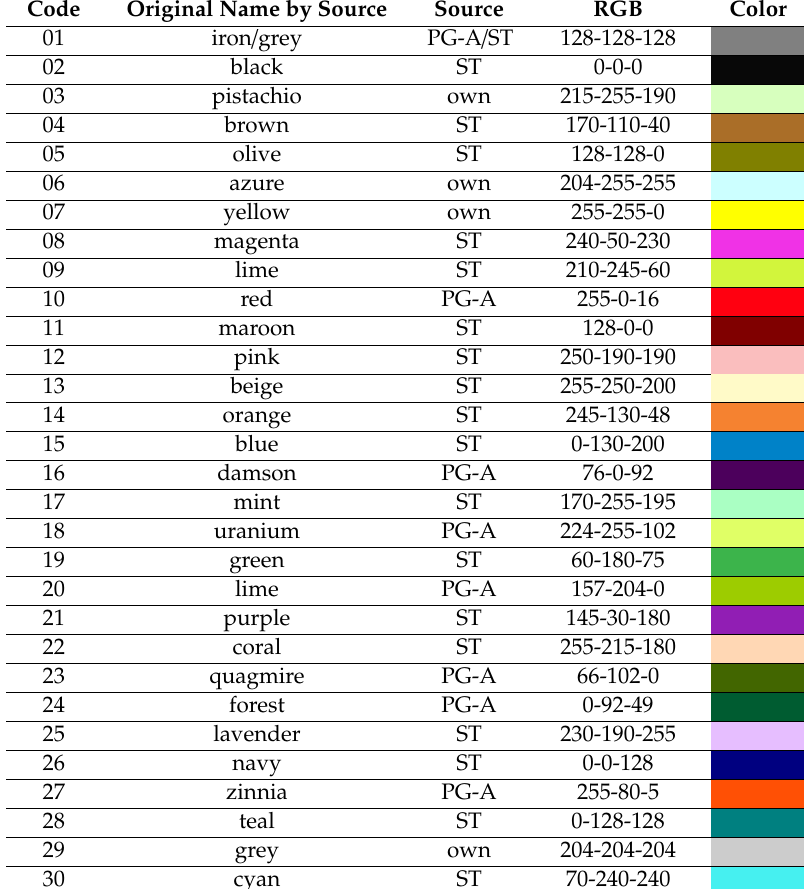
Table 1. Selected set of colors for representing pedestrians in the study according to the source (PG-A—Paul Green-Armytage; ST—Sasha Trubetskoy; own).